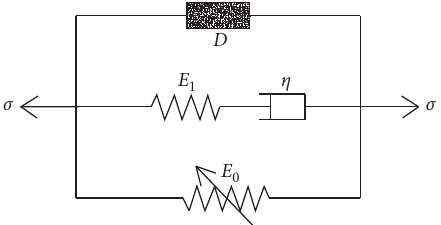
Figure 6: New nonlinear viscoelastic constitutive